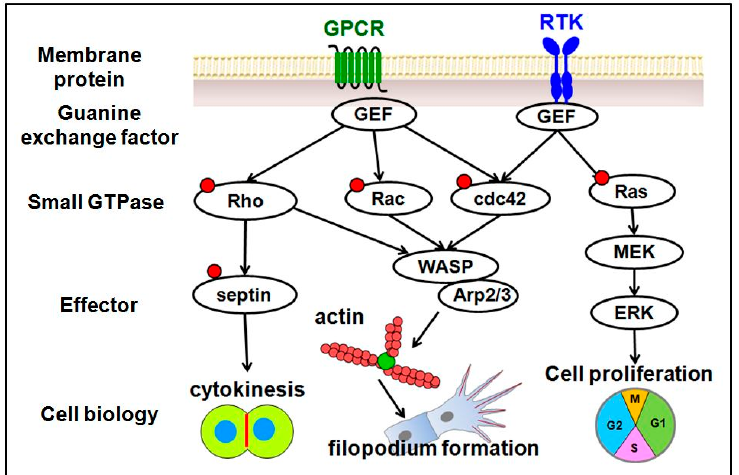
Figure 3. Schematic drawings of the proteins involved in GTPase signals and cellular function re- lated to the cell biological process of vascular